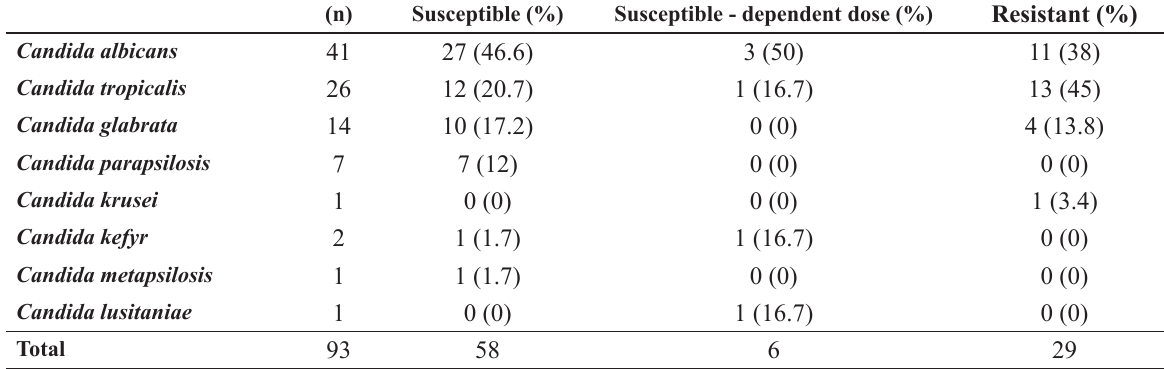
Fluconazole susceptibility profile of Candida spp.